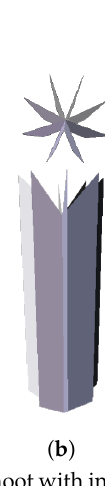
Figure 5. Example of a 3D representation of a spruce shoot with individual needles ( a ), and a simplified representation with planes along the central shoot axis ( b ) having total area equal to the leaf area of the corresponding needles.